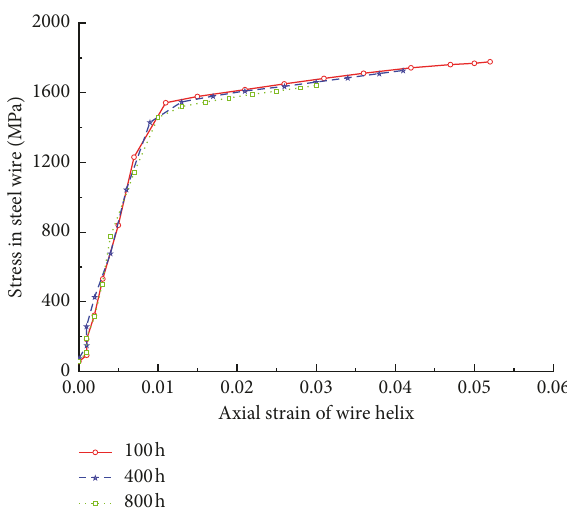
Figure 7: Effect of uniform corrosion depth on mechanical properties of steel